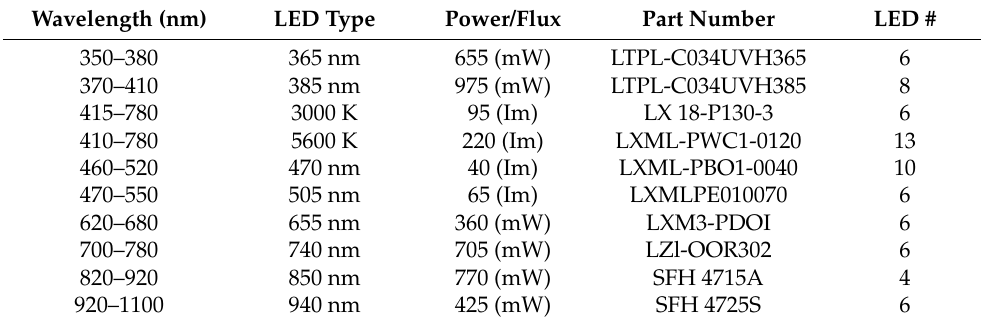
Table 2. Characteristics of the 10 selected LED types for one hexagon module solar